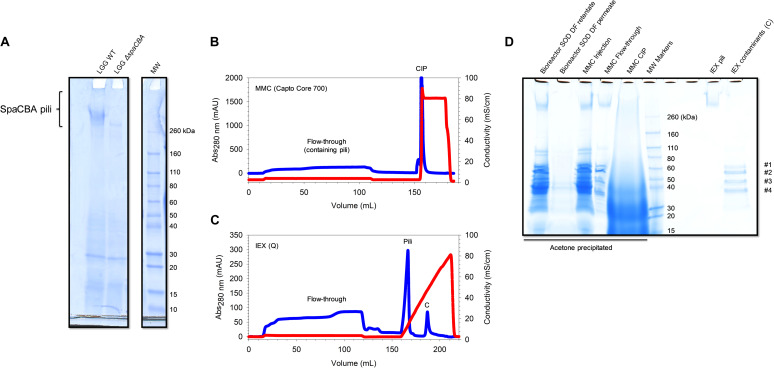
SpaCBA pili purification from LGG. (A) SDS-PAGE analysis highlighting the absence of pili production in LGG ΔspaCBA
(B) Multimodal chromatogram (Capto Core 700) and (C) ion exchange chromatogram (HiTrap Q HP). Blue lines correspond to Abs280nm signal and red lines to conductivity. (D) SDS-PAGE analysis throughout the purification process. SOD: supernatant of digestion, DF: diafiltration, MMC: multimodal chromatography, CIP: cleaning in place, IEX: ion exchange chromatography.